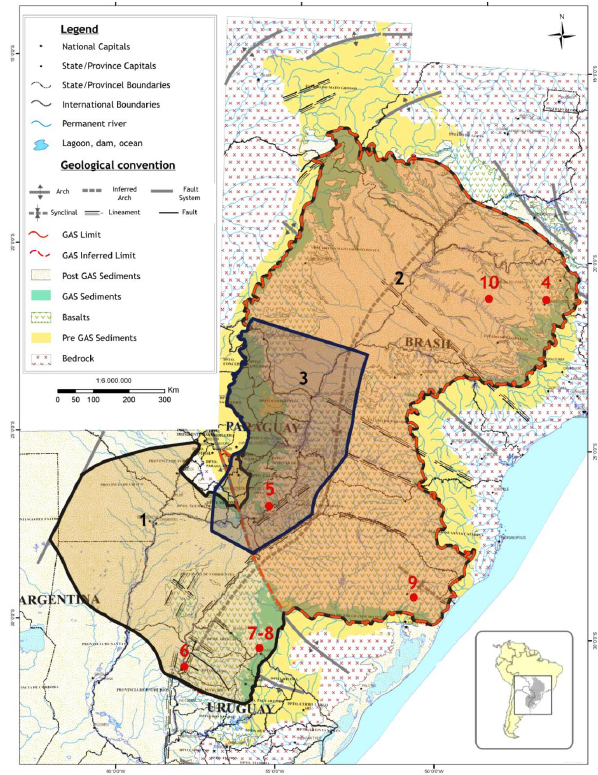
Fig. 1. Location of the Guaran´ı Aquifer System. Boundaries of GAS groundwater flow models: (1) this work; (2) Vives et al. (2001); (3) Vassolo (2007); (4) SNC Lavalin Internacional (2008a); (5) SNC Lavalin Internacional (2008b); (6) SNC Lavalin Interna- cional (2008c); (7) SNC Lavalin Internacional (2008d); (8) G´omez et al. (2010); (9) Heine (2008); (10) Rabelo and Wendland